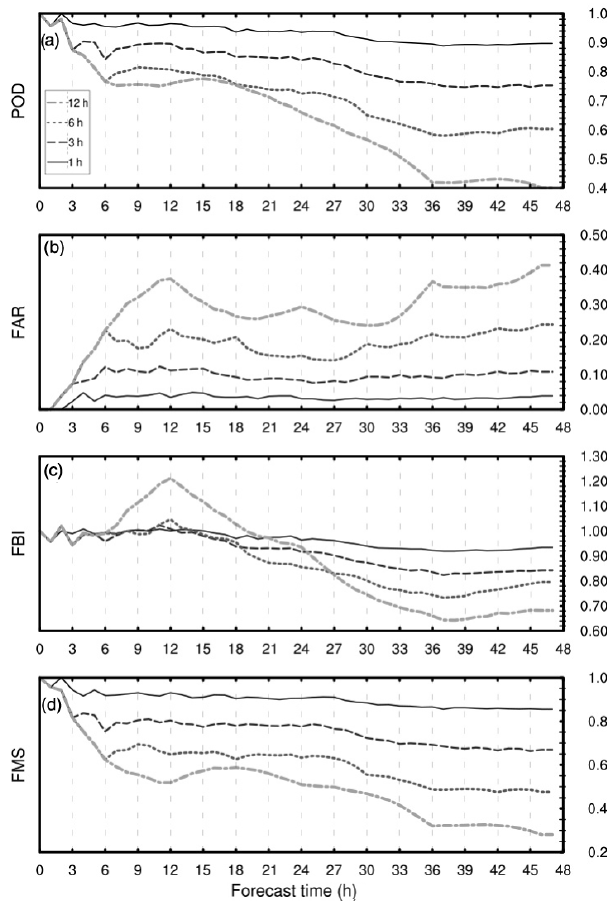
Figure 4. Categorical evaluation scores for the NMMB- MONARCH-ASH synthetic case including (a) probability of detec- tion (POD), (b) false alarm ratio (FAR), (c) frequency bias (FBI), and (d) Figure of Merit in Space